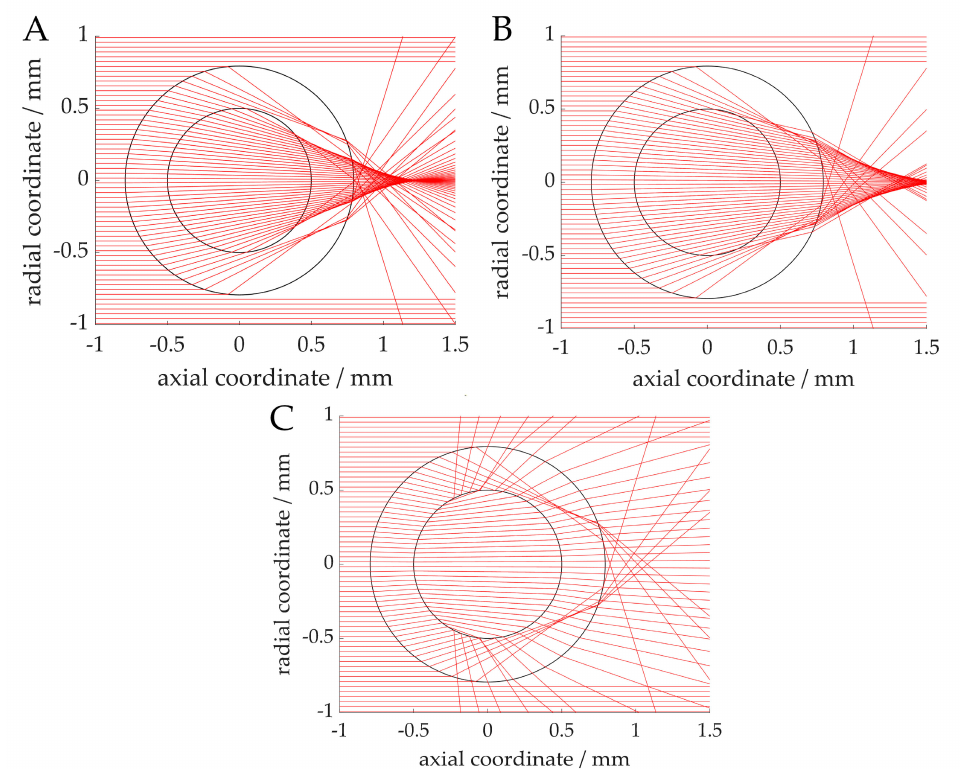
Figure 6. Simulated light refraction through capillary in vertical cross-sectional view. External medium: air, capillary: FEP, wall-film: 1-hexanol (not visible due to its low thickness), internal medium: 1-hexanol (no wall film, ( A )), water ( B ), nitrogen ( C ). The phototransistor can be assumed to be located at approximatively the 1 mm axial coordinate.